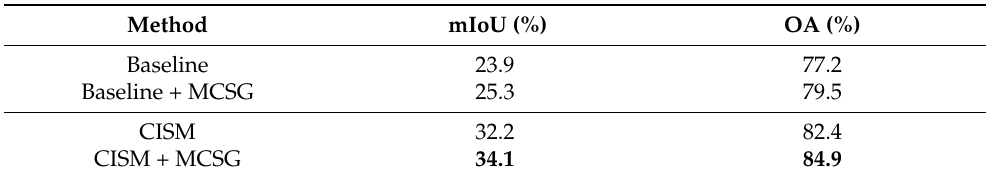
Table 7. Ablation research of the effectiveness of the multi-category sample generation strategy. The mIoU (%) and OA (%) are the evaluation indicators of CAM